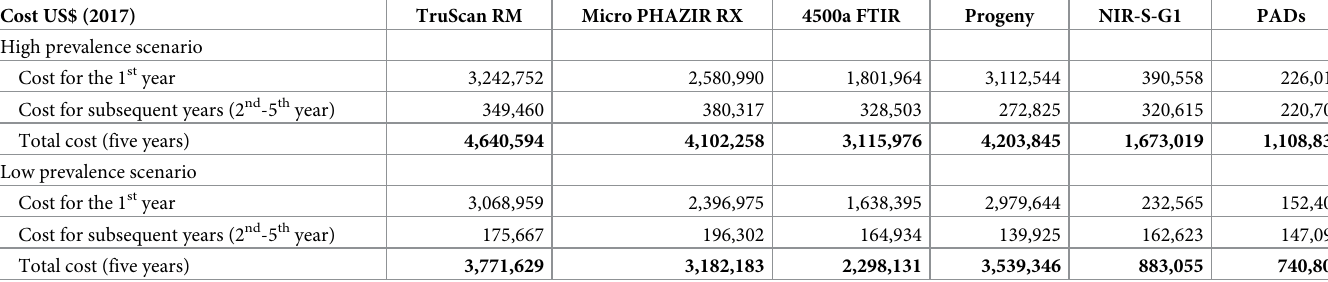
Table 8. Budget impact analysis under high and low prevalence scenario with a 1-sample strategy across all 42